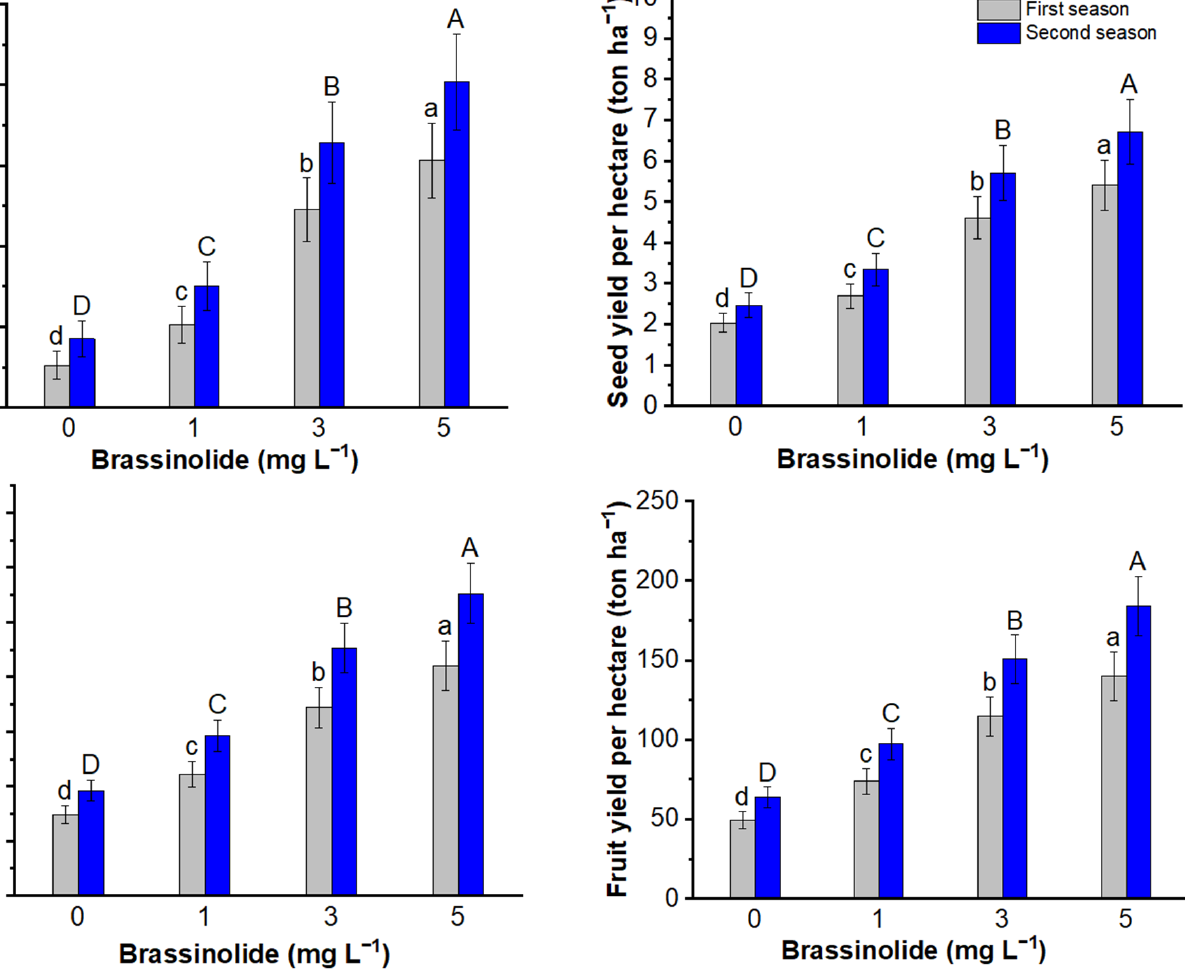
Figure 3. Seed yield plant − 1 (kg), seed yield ha − 1 (ton ha − 1 ), fruit yield plant − 1 (kg), and fruit yield ha − 1 (ton ha − 1 ) of Opuntia ficus-indica L. plant subjected to brassinolide foliar spray. Data are mean value ± SE. Bars with the same letters (lowercase for the first season and uppercase for the second season) are not significant at p ≤ 0.05 level.